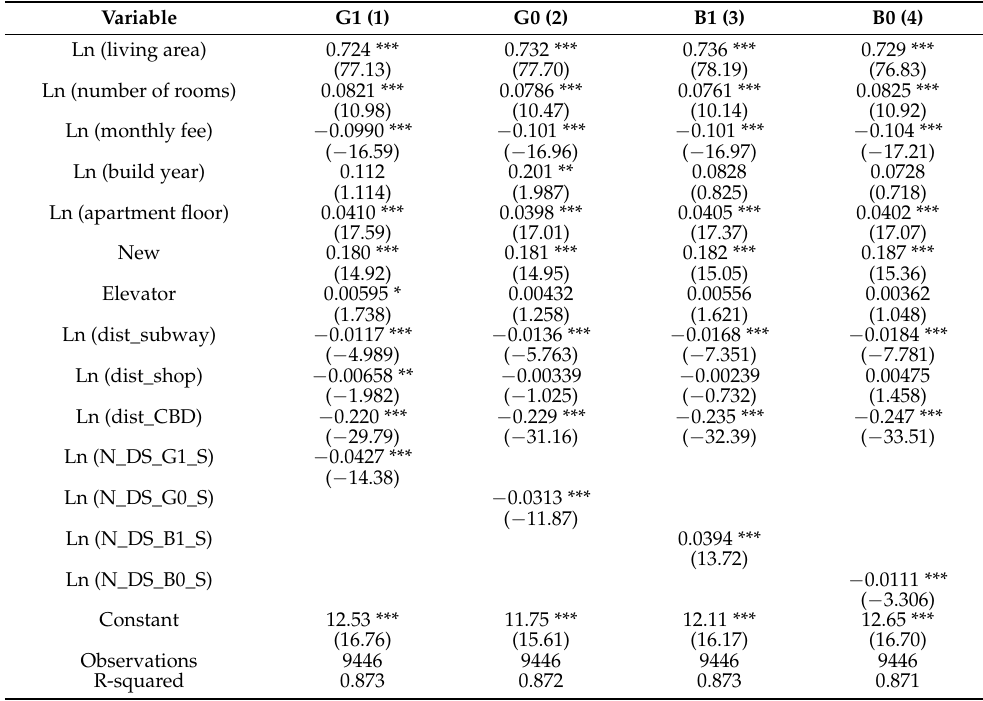
Table A3. HPM results are controlled by being close to a park for Measure